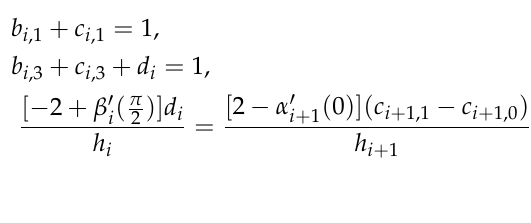
Figure 7. Some plots of generalized quasi cubic trigonometric B-spline basis functions with α i ( t ) and β i ( t ) given in Equation (13) and Equation (14), when λ = ( 3,3,3 ) , µ = ( 5,2,5 ) ; λ = ( 3,3,3 ) , µ = ( 10,4,10 ) ; λ = ( 3,3,3 ) , µ = ( 20,20,20 ) .